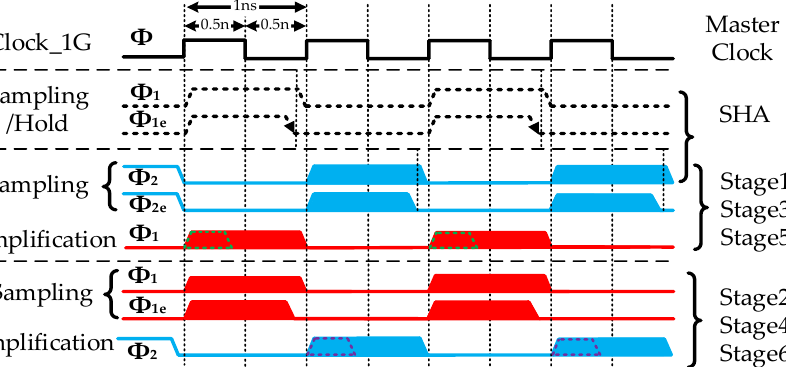
Figure 2. The traditional timing, including the sampling phase and the amplification phase. Detailed timing is provided for SHA, Stage1~Stage6. φ 1 , φ 1e , and φ 2 are provided for Stage1, Stage3, and Stage5 to sample and amplify. φ 2 , φ 2e , and φ 1 are provided for Stage2, Stage4, and Stage6 to sample and amplify. The green and purple parts represent quantization.